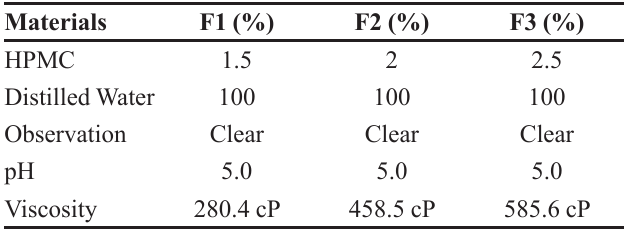
TABLE I - The optimization result of gel basis Materials